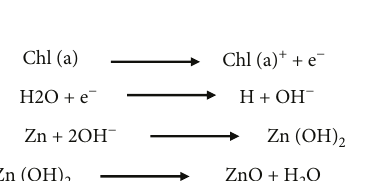
Figure 1: Chlorophyll a (Chl a).